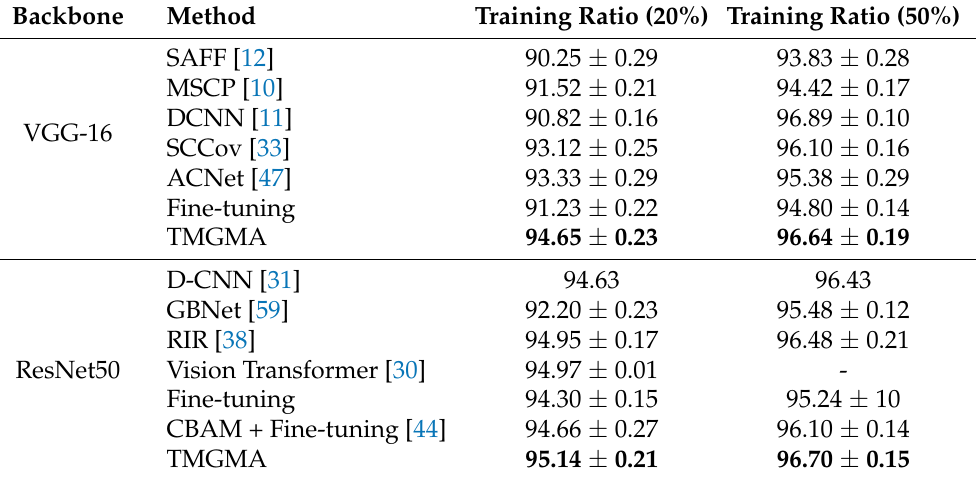
Table 2. Classification accuracies (%) of the proposed TMGMA and other methods on the AID